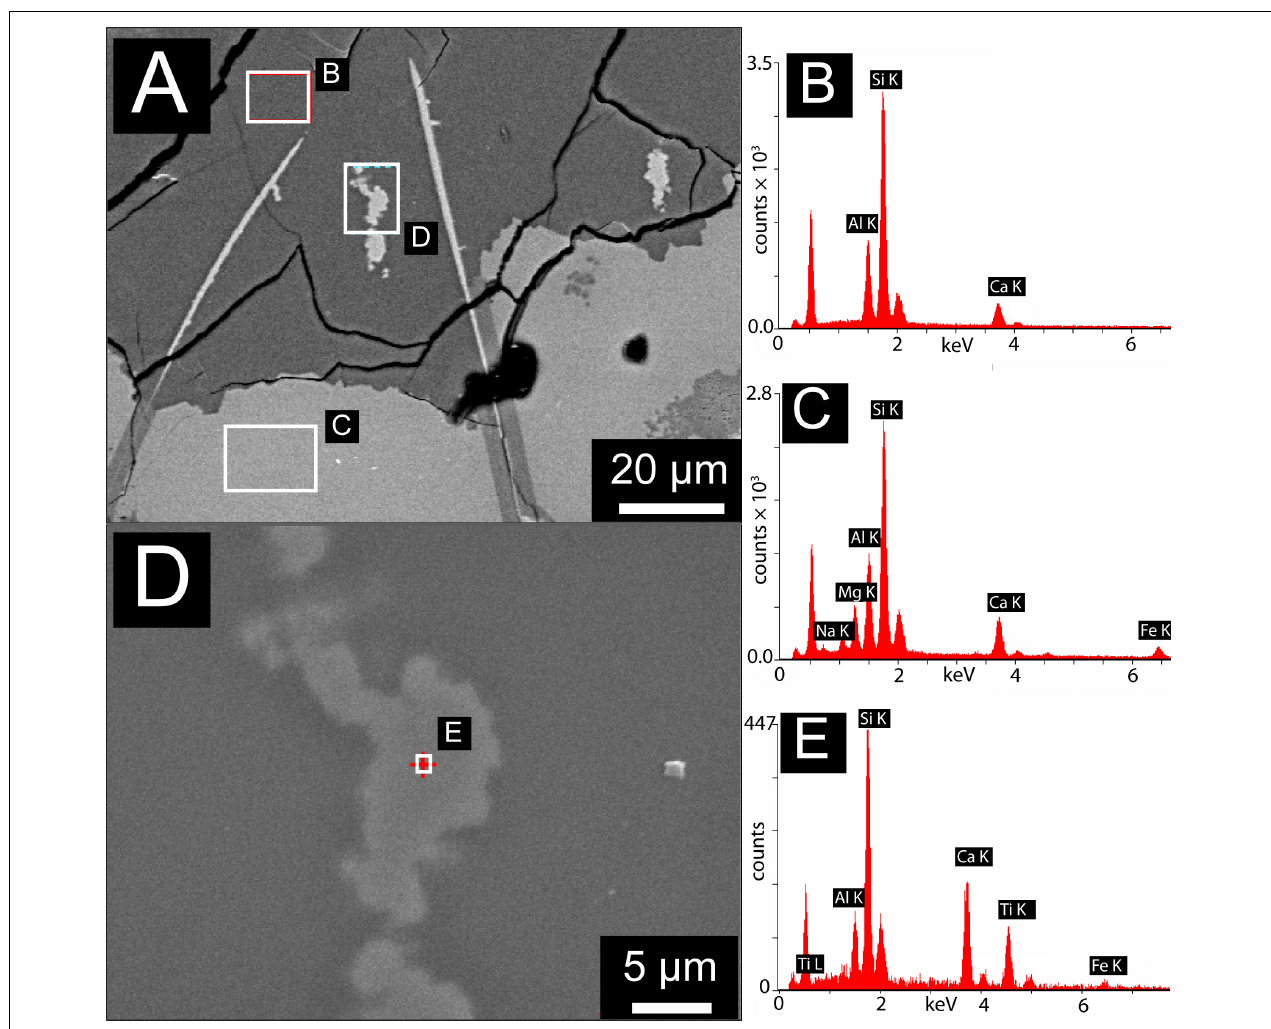
FIGURE 10 | Scanning Electron Microscopy with Energy Dispersive X-ray Spectroscopy (SEM-EDX) results for a representative region containing both unaltered basaltic glass and zeolite alteration containing titanite-mineralized tubules. (A) SEM Back Scattered Electron (BSE) image showing zeolitic alteration (dark gray) containing titanite-mineralized tubules (visible here as bright areas exposed at the surface of the zeolite host, e.g., area labeled “D”). Also visible are unalted basaltic glass (light gray) and isolated linear features filled with fine-grained Fe-oxyhydroxides (bright linear features cross-cutting between glass and zeolite). (B) EDX spectrum of the area marked by the corresponding box in (A) , showing the presence of Al, Si, and Ca, consistent with the calcian zeolite alteration assemblage. (C) EDX spectrum of the area marked by the corresponding box in (A) , showing the composition of unaltered basaltic glass. (D) High magnification image of a titanite-mineralized tubule exposed at the surface of the thin section, this region is marked by the corresponding box in (A) . (E) EDX spectrum of the point marked by the cross in (A) , showing elevated concentrations of Ca and Ti, consistent with titanite and in accord with µ XRD diffractograms and optical images showing the presence of titanite in these